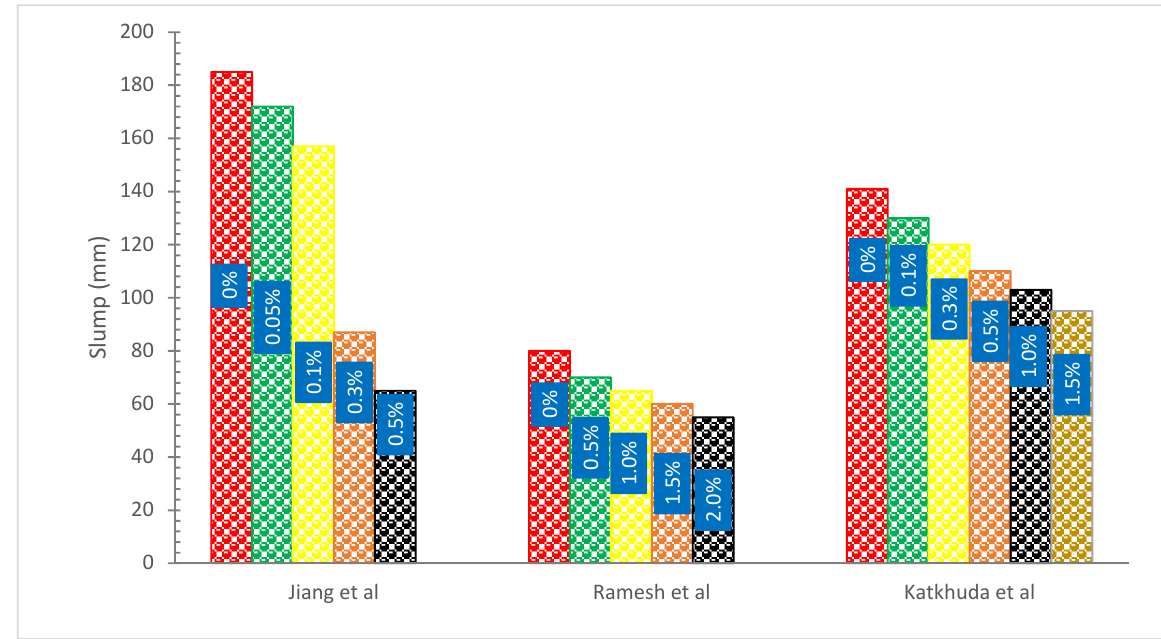
Figure 3. Slump Flow of Concrete: Data source [31,36,50]. It was discovered that when the fiber proportion was raised, the slump values of concrete mixtures decreased. When fibers are added at volume fractions of 0.5, 1.0, 1.5, and 2.0 percent, the slump value is reduced to 70 mm, 65 mm, 60 mm, and 55 mm, respectively, from 80 mm for the control mix (BFs 0.0). It may be concluded that fibers added to the concrete mix may be to blame for the decline in workability. The viscosity of concrete may rise as a result of the fiber’s greater surface area needing to absorb much more cement paste [50]. Concrete with a higher BFs content has less slump. The reference concrete has a 185 mm slump. The slumps were decreased to 130, 90, 75, and 59 mm by adding BFs at volume fractions of 0.05, 0.1, 0.15, and 0.2 percent, respectively [51]. According to research [36], the fiber supplementation caused the droop to lessen somewhat. The slump for ordinary concrete is 185 mm. The droop decreases to 142, 124, and 59 mm, respectively, when volume fractions of 0.05, 0.1, and 0.3 percent of polypropylene fibers are added. The droop decreases to 172, 157, 87, and 65 mm, respectively, when BFs with volume fractions of 0.05, 0.1, 0.3, and 0.5 percent are added. It may be inferred that the inclusion of fibers may result in a reduction in fluidity. The dispersed fiber in the concrete, which may create a network structure, is what causes this occurrence because it inhibits the blend from separating and flowing. Because fibers have great content and a big surface area, they may absorb more cement paste to cover them. This causes the blend to become stickier, which lowers the slump [52]. In addition, adding 22 mm BFs to concrete results in a greater slump than adding 12 mm BFs with the same volume percentage. Shorter fibers may have more fibers per unit volume and a higher fiber distribution density, which might be the cause. The slump of the concrete may decrease as a consequence of the increased difficulty the fibers have in dispersing evenly inside the matrix [36]. According to one study [53], fibers with short lengths flow more easily than fibers with longer lengths. Limited-length fibers increase the surface area of the fiber cement paste, improving its ability to bond